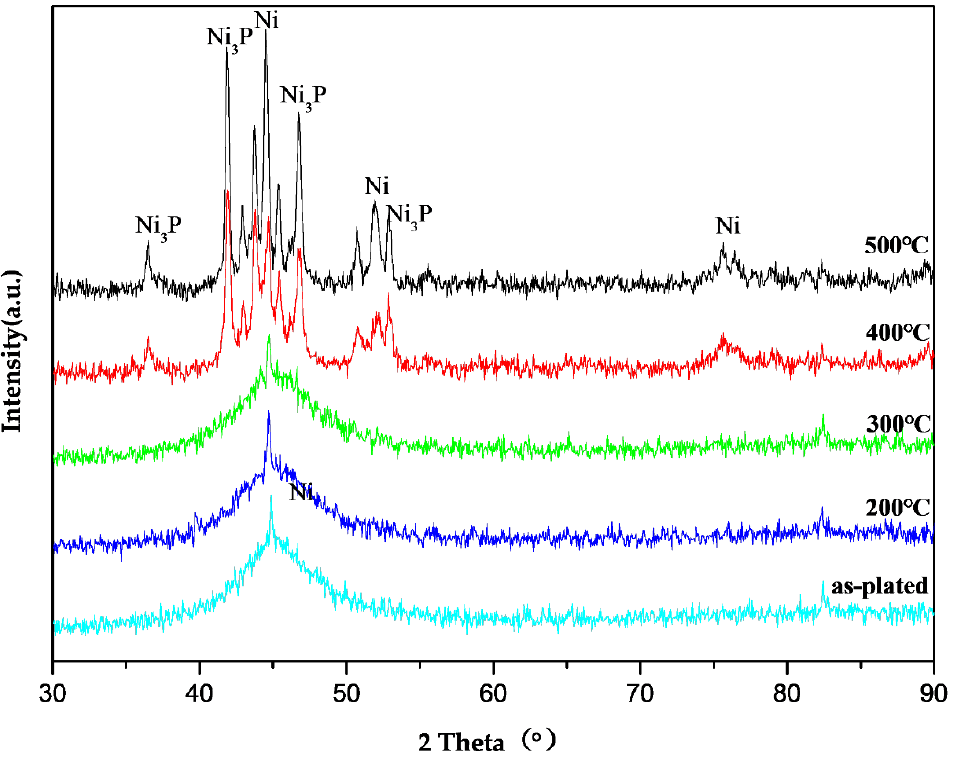
Figure 1. XRD patterns of Ni-P coating treated under different temperatures.